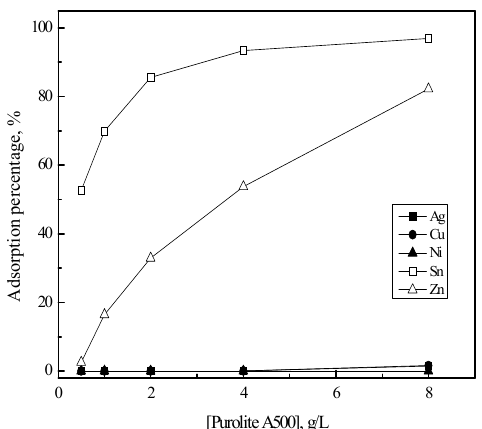
Figure 3. Effect of Purolite A500 concentration on the adsorption of metals in 5 M HCl solution. [Purolite A500] = 0.5–8 (g/L), time = 6 h, shaking speed = 200 rpm. Adsorption into Diaion WA21J is shown in Figure 4. As resin concentration increased from 0.5 to 8 g/L, the adsorption percentage of tin(II) and zinc(II) increased almost linearly to 80% and 50%, respectively. However, only 5% of silver(I) was adsorbed into the resin when resin concentration was